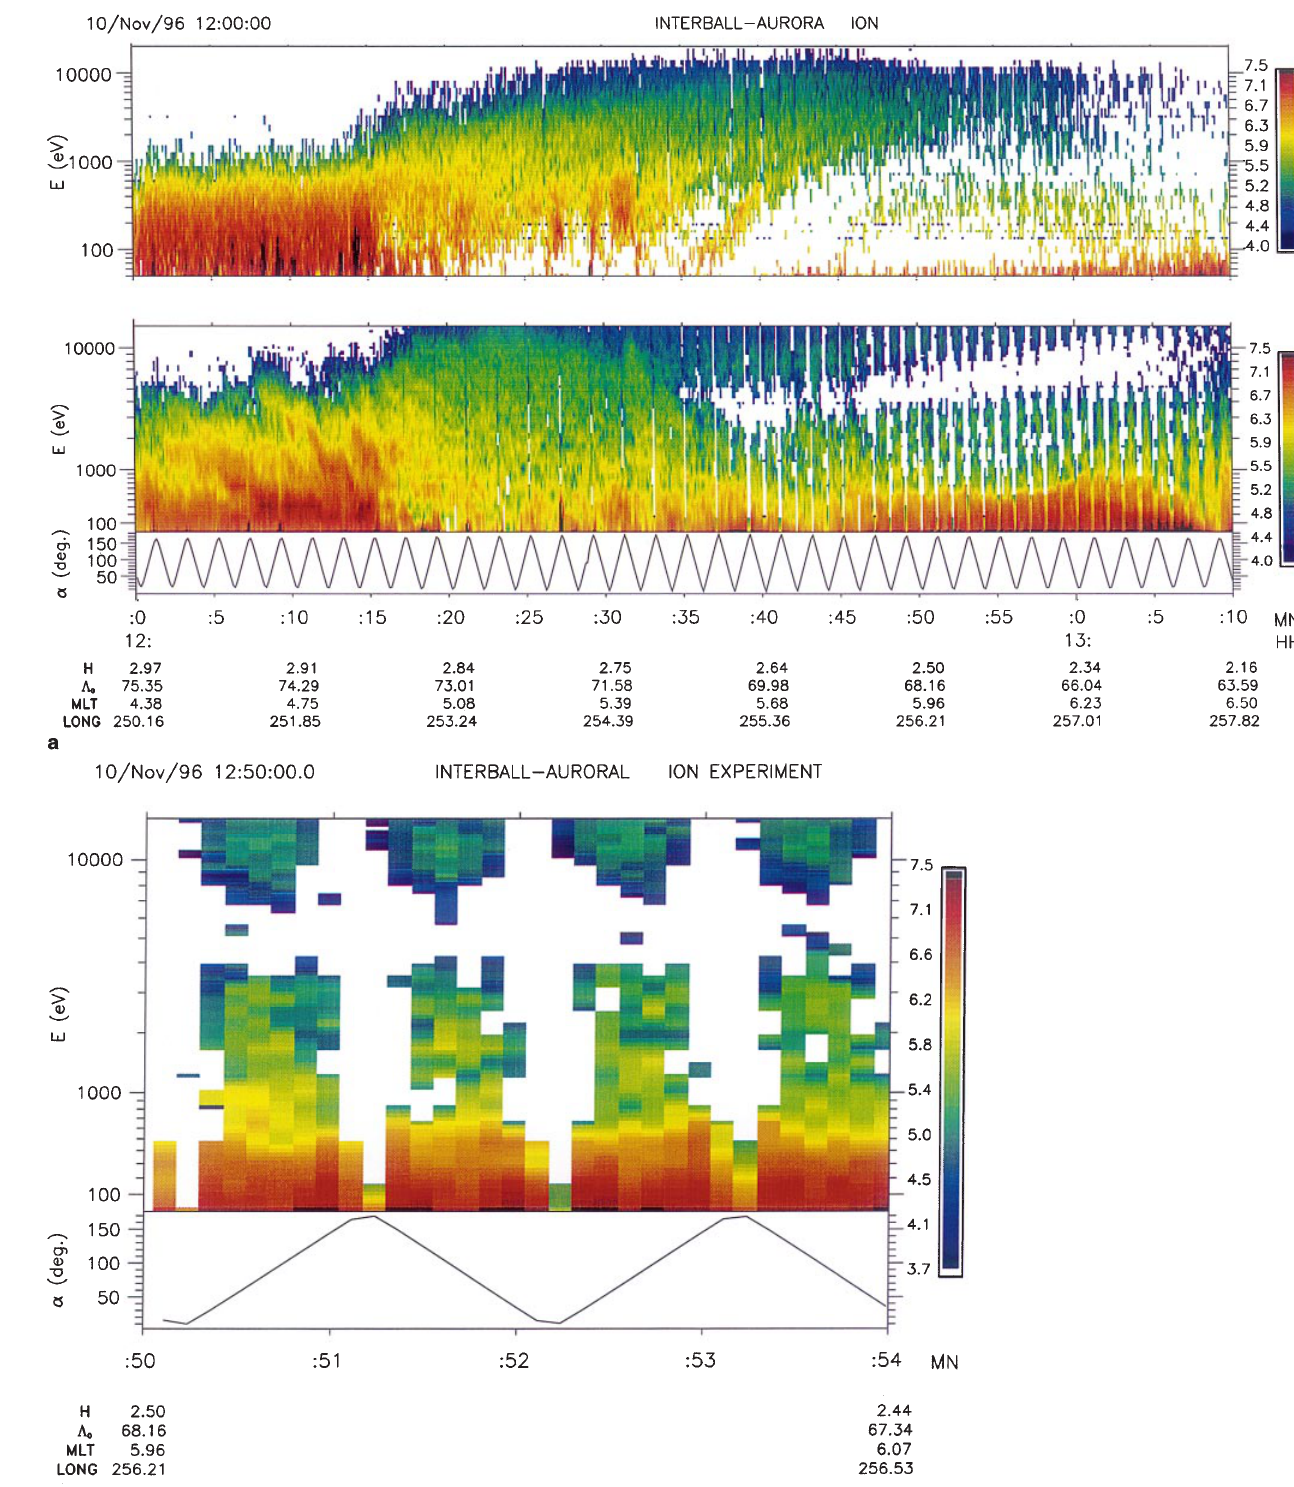
Fig. 1. a ( Top ) electron and ( bottom ) ion energy-time spectrograms recorded by INTERBALL-Auroral on November 10, 1996 from 1200 to 1310 UT. Fluxes in (cm 2 .sec.ster.keV) ) 1 . Pitch angle versus time is